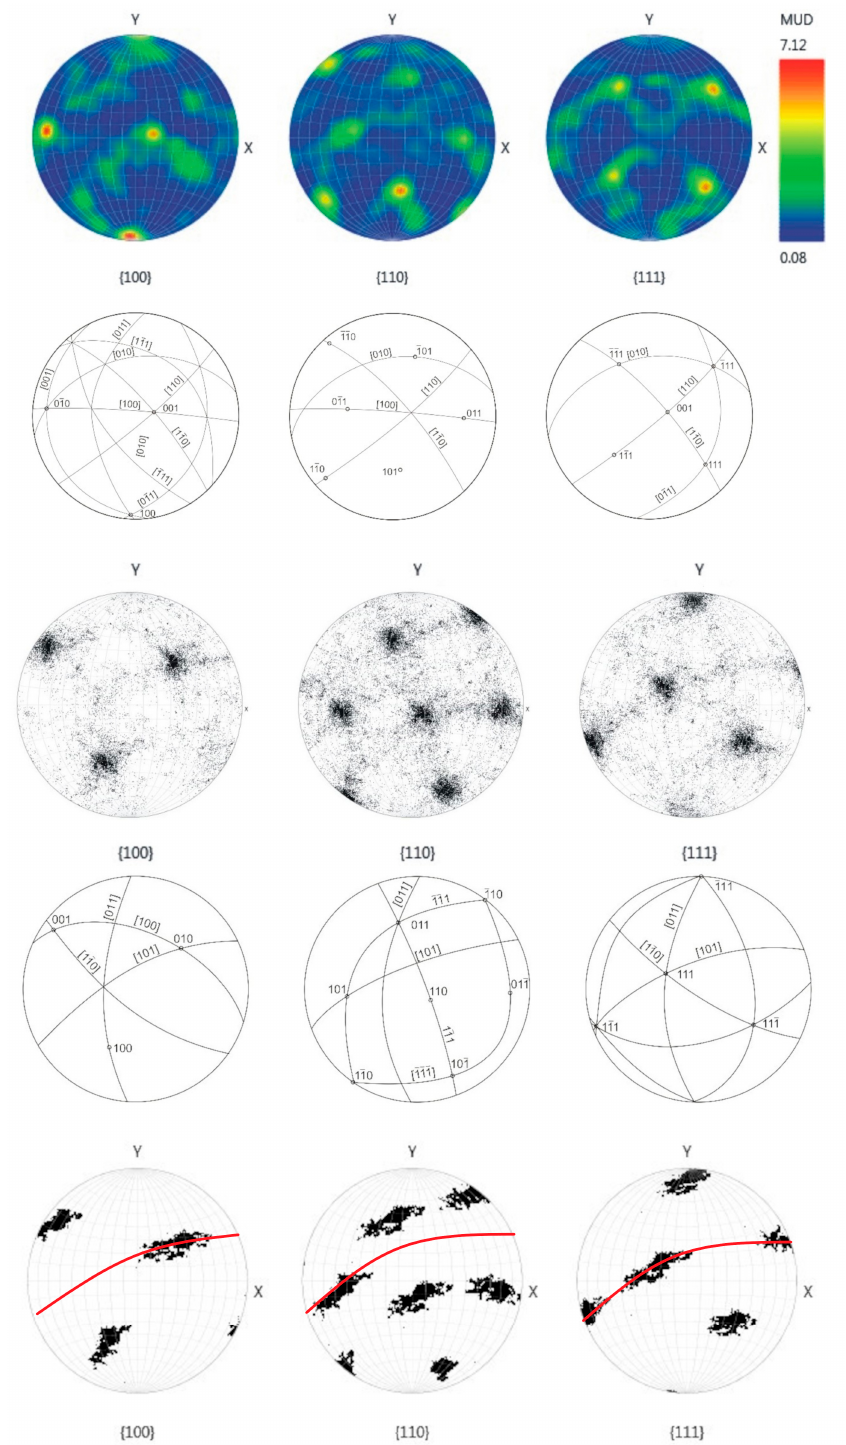
Figure 5. Stereographic diagrams and crystallographic interpretation of reflection positions on Schmidt plots, EBSD data. Positions of 100, 110, 111 reflections along {100}, {110}, {111} directions. Two upper rows—the central part of the “large” specimen; other rows correspond to the whole studied surface. The thin red line in the bottom row shows the {110} plane. Schemes show projections of crystallographic directions and clustering of the re fl ections.